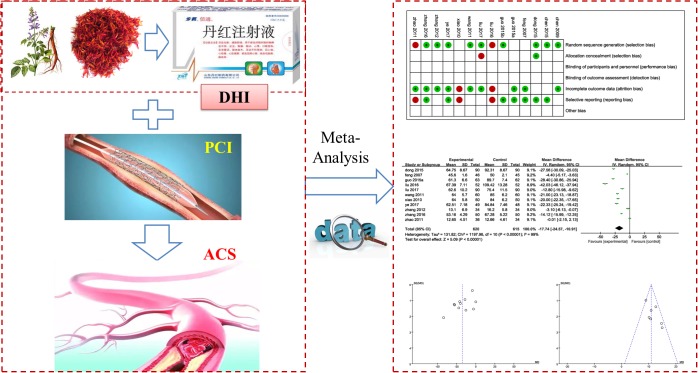
Work flow of present study.